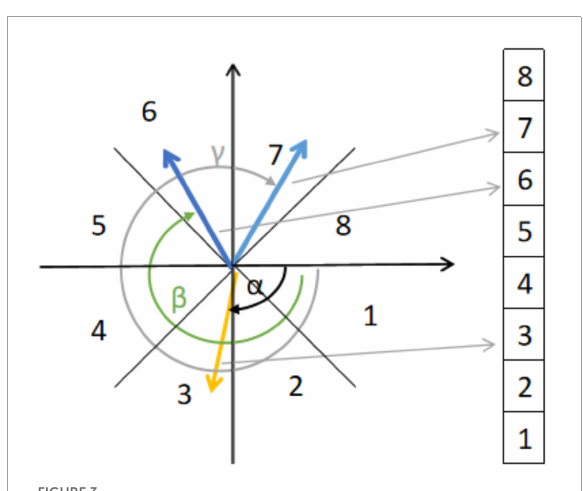
FIGURE3 Histogram of oriented optical flow with eight